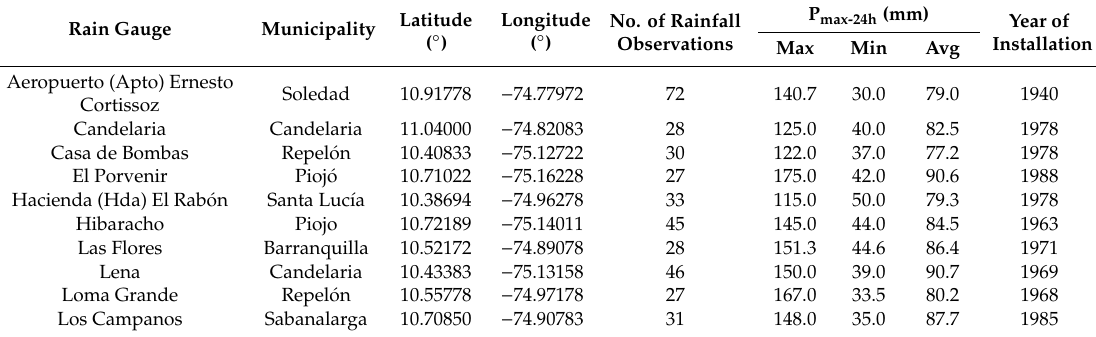
Table 2. Rain gauges selected in the department of Atlántico. Max—maximum; Min—minimum; Avg—average.